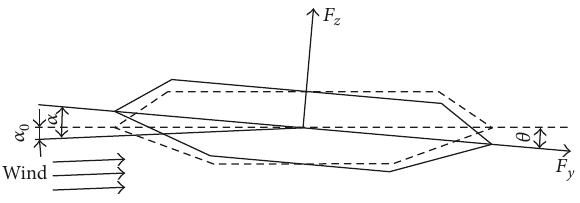
Figure 2: Three components of aerostatic